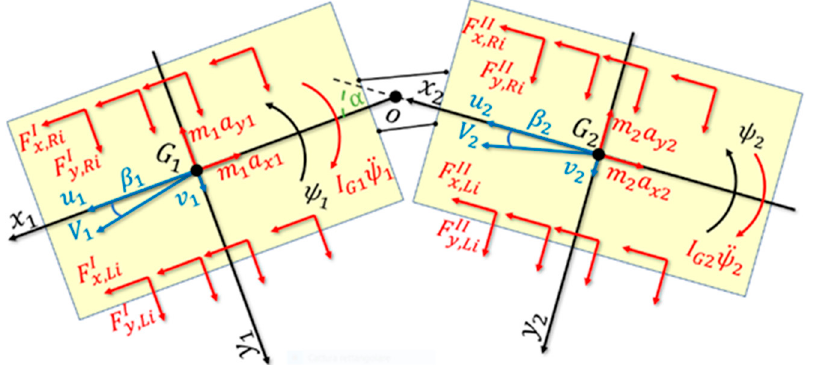
Figure 2. Free body diagram of ATV (top view). Reprinted with permission from ref. [19]. Copy- right 2020 Springer Nature Switzerland AG.